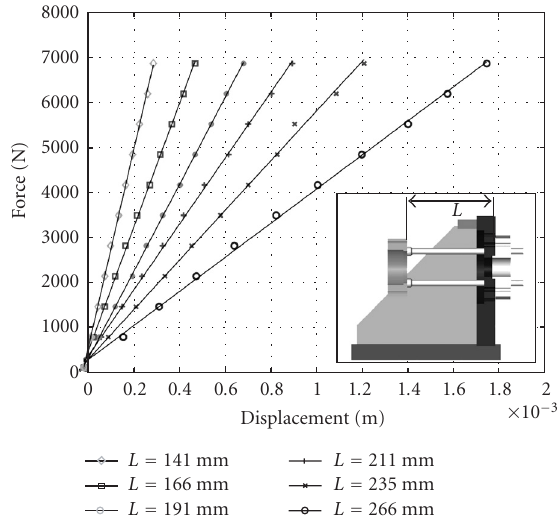
Figure 4: Estimated static sti ff ness for various lengths of the beams and di ff erent static forces.